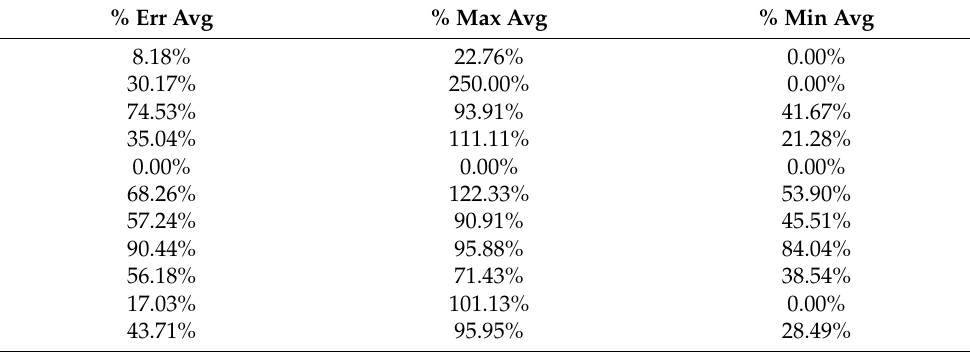
Table A209. Set 3, trials 31–40 data (single 0.5 PR value).